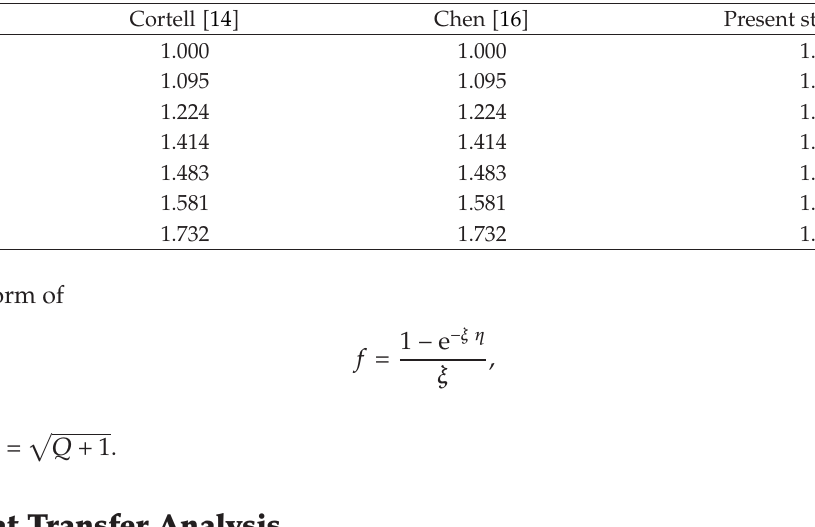
Table 2: Comparison of − f (cid:5)(cid:5) (cid:5) 0 (cid:6) for various values of Q when β (cid:8) 0, Gr (cid:8) 0, A ∗ (cid:8) 0, B ∗ (cid:8) 0, Ec (cid:8) 0, and Pr (cid:8)